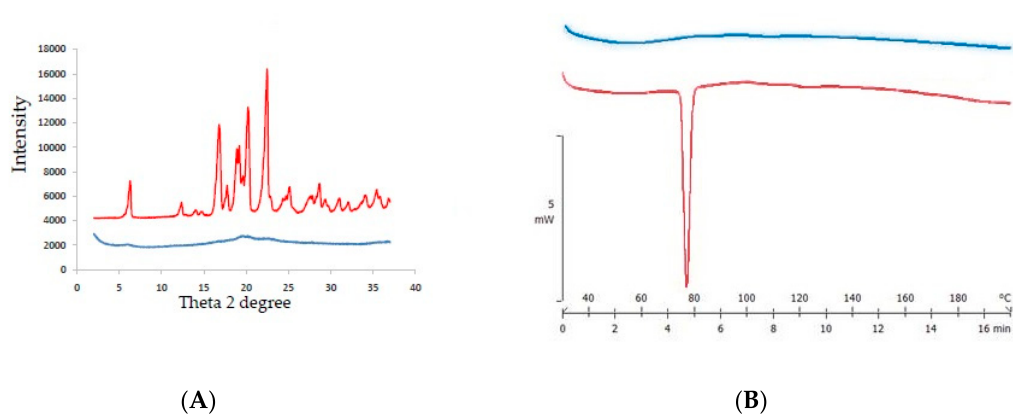
Figure 6. ( A ) XRPD diffractogram and ( B ) DSC thermograms of the physical mixture (IBU 50%, Neusilin 50% (red)) and the HMI extrudate (IBU 50%, Neusilin 50% (blue)).